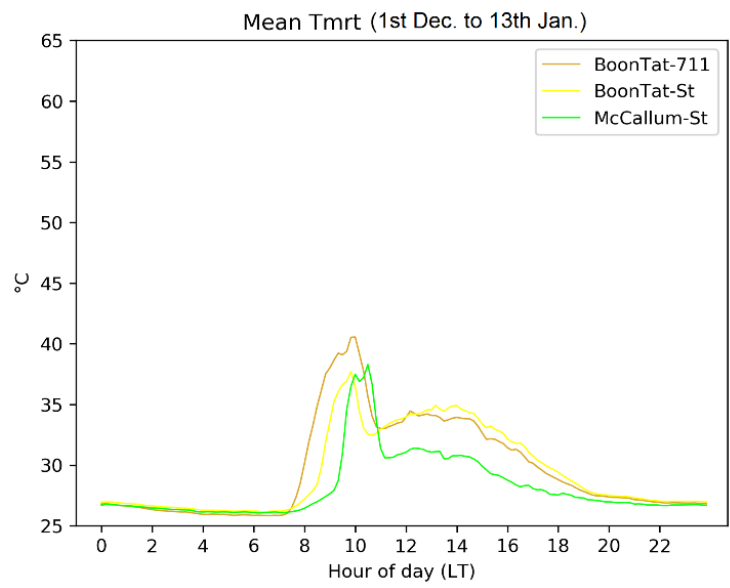
Figure 11. Mean T mrt diurnal cycle (from 10-min averaged data) in BoonTat711, BoonTatSt, and McCallumSt in the CBD area during the wet NE-Monsoon season (1 December 2019 to 13 January 2020). During the evening, T mrt difference between BoonTat sites and McCallum slowly reduces. By sunset ( ≈ 19:00), when incoming solar radiation is negligible, all three sites register similar T mrt values. Figure 12 represents the effect of increasing the diffuse solar radiation (above the urban canopy) on the T mrt difference between a high SVF site (BoonTatSt/BoonTat711) and a low SVF site (McCallumSt) in the absence of direct solar radiation. The diffuse solar radiation is measured at a nearby roof top. Results show that under higher incoming diffuse radiation, the T mrt difference between a low SVF and a high SVF site also tends to increase, which is influenced by higher levels of diffuse radiation reaching the pedestrian level in the high SVF site. This outcome is aligned with the result presented in a previous paragraph showing that under shadow conditions, low SVF street canyons reduce radiative fluxes at the pedestrian level and thus show lower T mrt